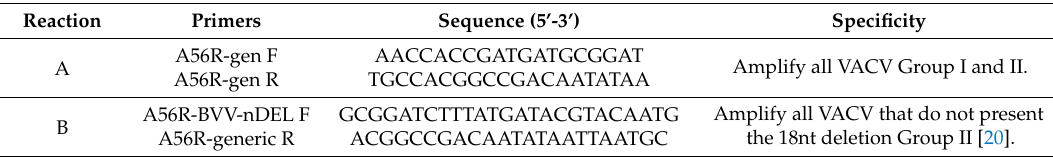
Table 1. Real-time PCR